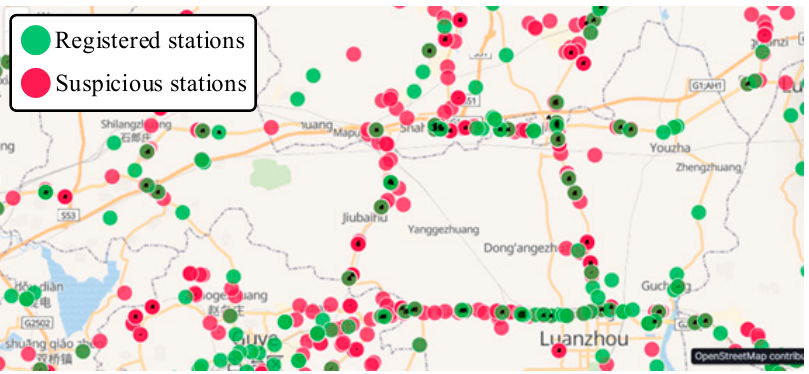
Figure 4. Distribution of detected refueling points in Tangshan.